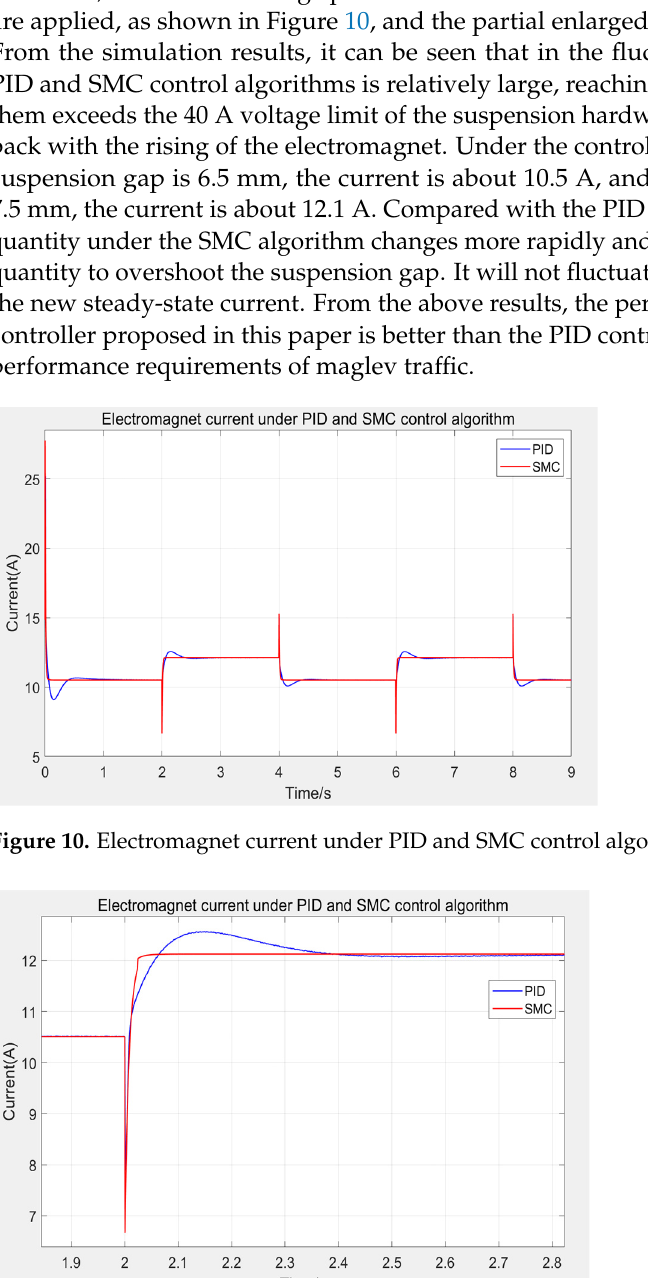
Figure 12. Curve tracking using SMC and PID under external force.